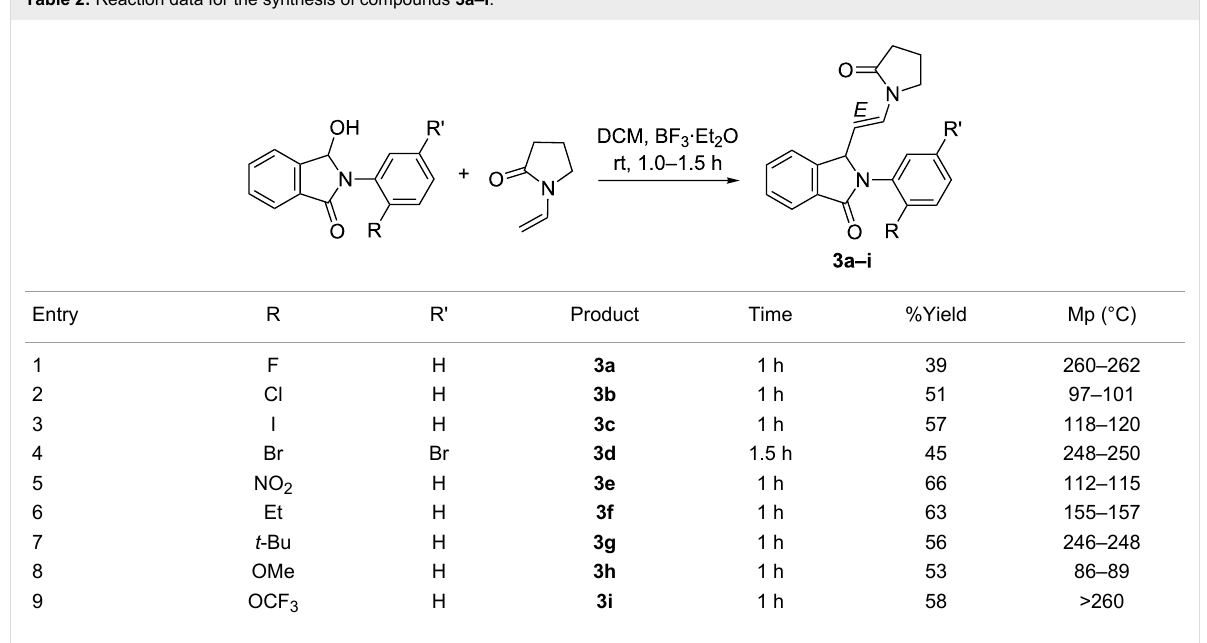
Table 2: Reaction data for the synthesis of compounds 3a–i .